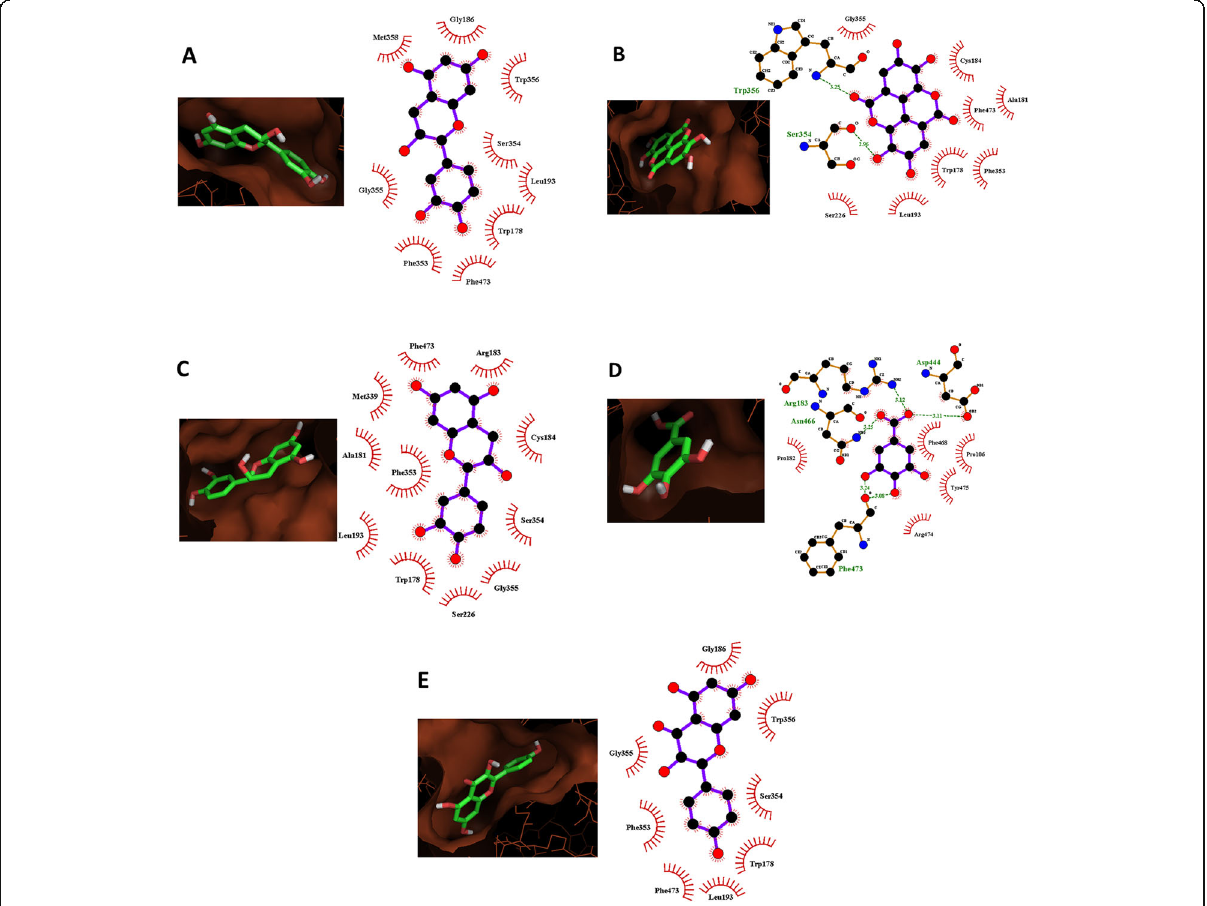
Fig. 5 The binding configurations of M. indica phytoconstituents and interaction analysis. Binding poses of a Catechin, b Ellagic acid, c Epicatechin, d Gallic acid, and e Kaempferol on NOS active site as obtained from molecular docking using Autodock Vina. Result of 2D interaction analysis shows hydrogen bond (green dashed lines) and hydrophobic interaction (red curved lines) using